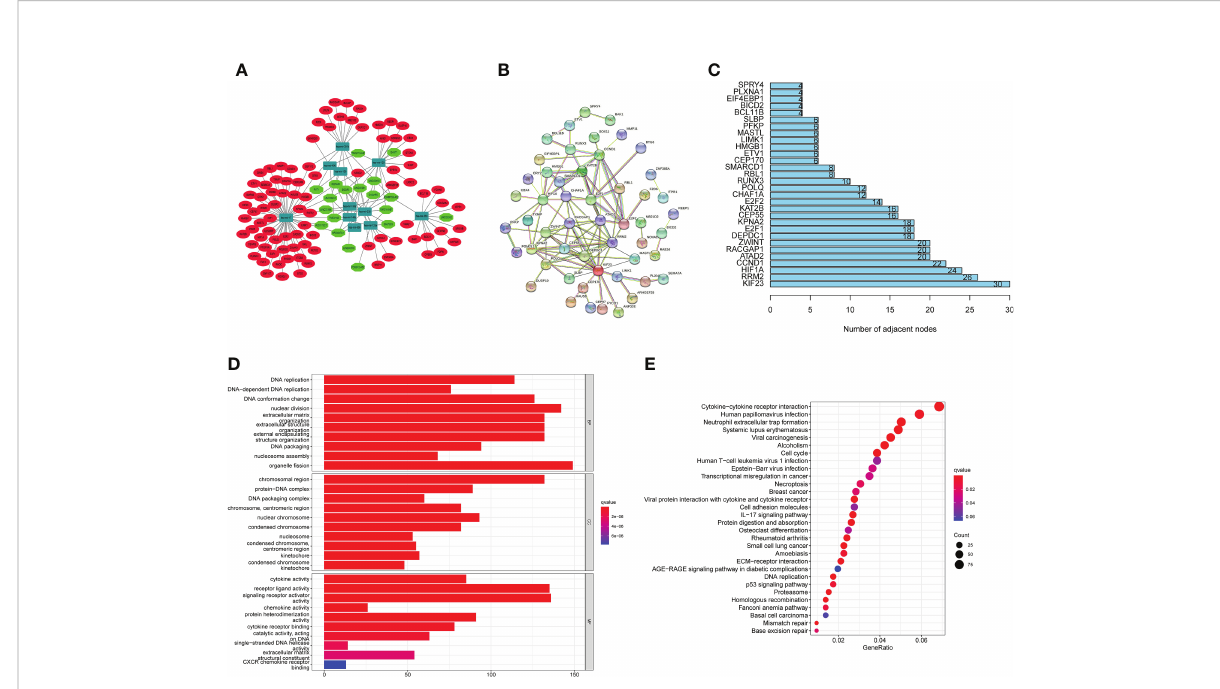
FIGURE 7 CeRNA network construction, PPI network analysis and functional enrichment analysis. (A) CeRNA network according to the expression pro fi les of 19 miRNAs, 11 lncRNAs, and 90 mRNAs in EC patients. (B) PPI analysis was performed on these 90 target mRNAs. (C) Bar chart displaying the a PPI network with connection nodes for the top 30 targeted mRNAs. (D) An analysis of KEGG pathways shows that targeted mRNAs enriched signaling pathways. (E) GO enrichment analysis of targeted mRNAs uncovered the BP, CC, and